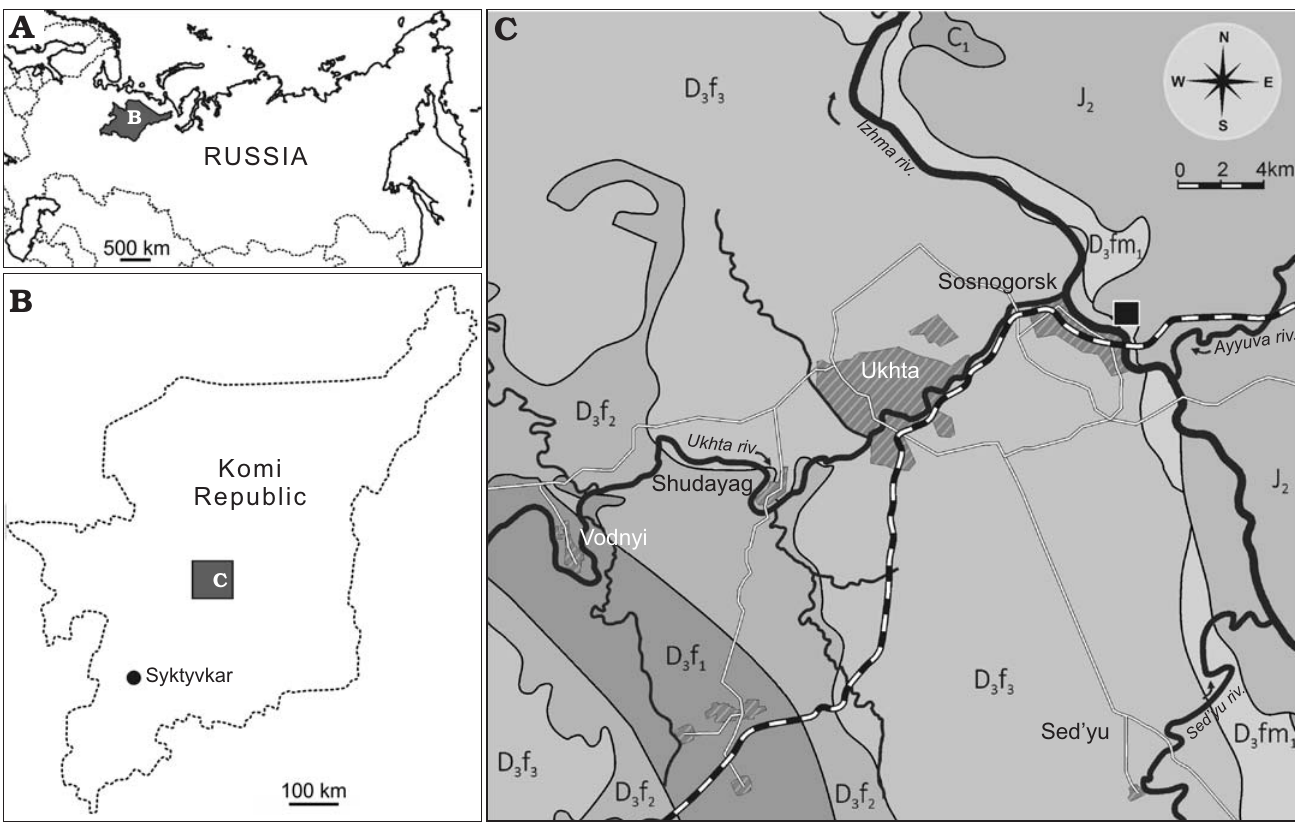
Fig. 1. Geographical and geological setting of the type locality of Bothriolepis leptocheira jeremejevi (Rohon, 1900): sketch-maps of Russia ( A ) and Komi Republic ( B ) and geological map of Ukhta-Sosnogorsk area, from Yukhtanov et al. (2008), amended ( C ). The Natural Geological Monument “Sosnovskiy” (Sosnogorsk fossil site) is marked by the black square. Abbreviations: D 3 f 1 , Upper Devonian, lower Frasnian; D 3 f 2 , Upper Devonian, mid- dle Frasnian; D 3 f 3 , Upper Devonian, upper Frasnian; D 3 fm 1 , Upper Devonian, lower Famennian; C 1 , Carboniferous, Mississippian; J 2 , Middle